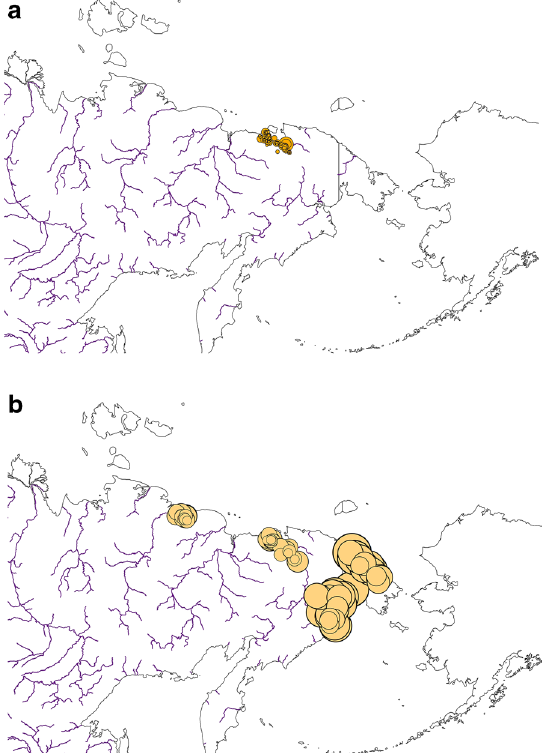
Figure 9. Field survey numbers for Greater White-fronted Goose ( Anser albifrons ) ( a ) broods, and ( b ) moulting non-breeders for the study area. Yellow circles are scaled ranging from 0 to 100 individuals (in b ) a log scale was used ranging from 0 to 10,000). Map created by FH with OpenSource QGIS and ArcGIS Desktop 10.6 academic